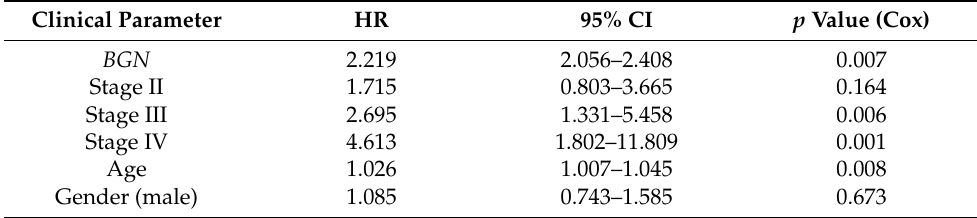
Table 1. Multivariate analysis of BGN expression and overall survival in stomach cancer cohort from The Cancer Genome Atlas (STAD-TCGA) gastric cancer cohort ( n =